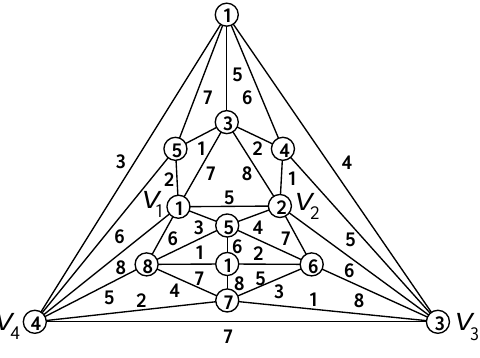
Figure 8. A total 8-coloring of J 13